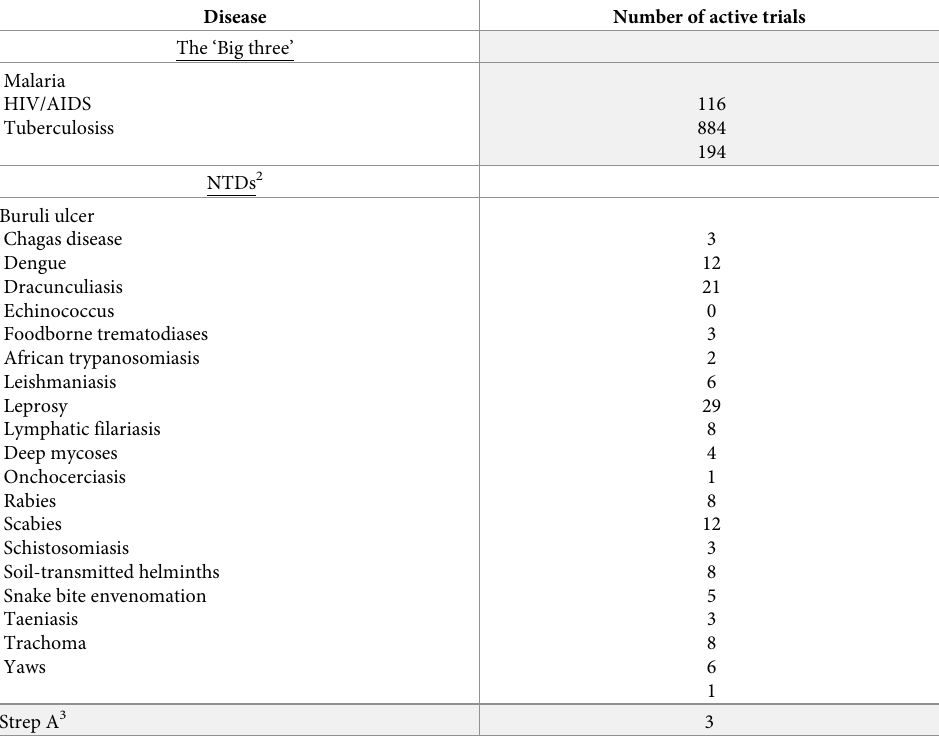
Table 2. Number of active clinical trials for various disease categories 1